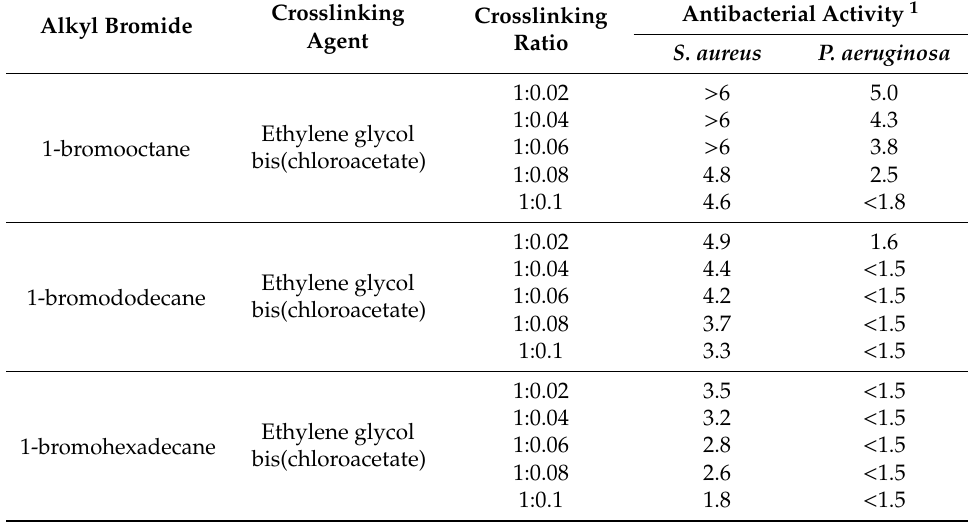
Antibacterial activity of QA-PEI nanoparticles prepared with the ethylene glycol bis(chloroacetate) crosslinker and di ff erent alkylation agent chain lengths against S. aureus and P. aeruginosa . Data from [84]. Alkyl Bromide